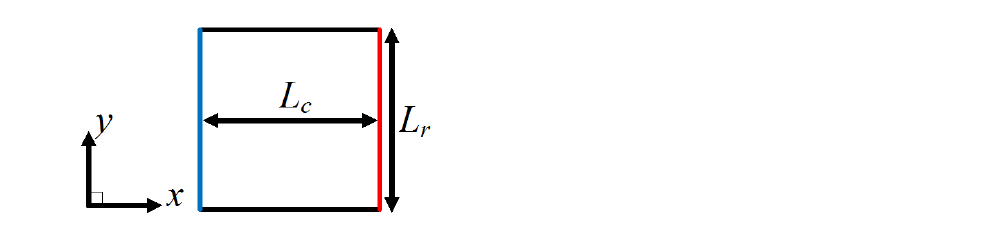
Figure 1. Schematic view of a square flexible plate. The leading edge is indicated by the red line and the trailing edge is indicated by the blue line.